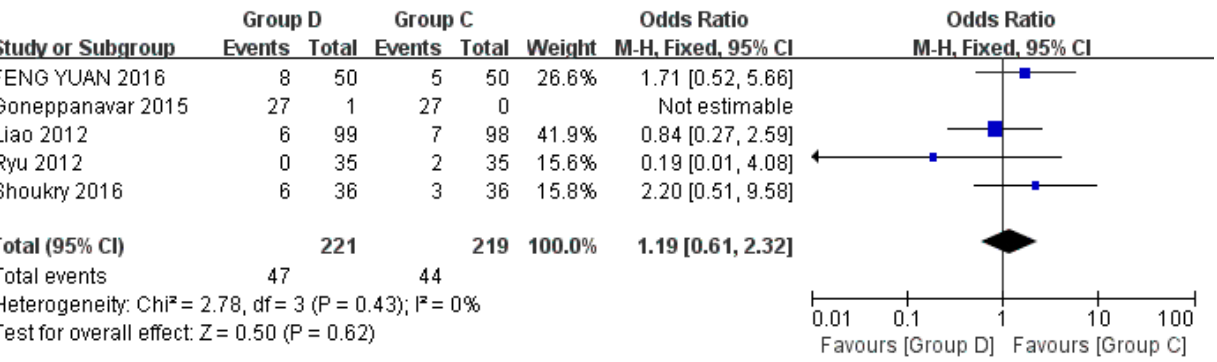
Figure 6. Forest plots comparing the effects of dexmedetomidine and control group on hypotension [22–24,28,29].